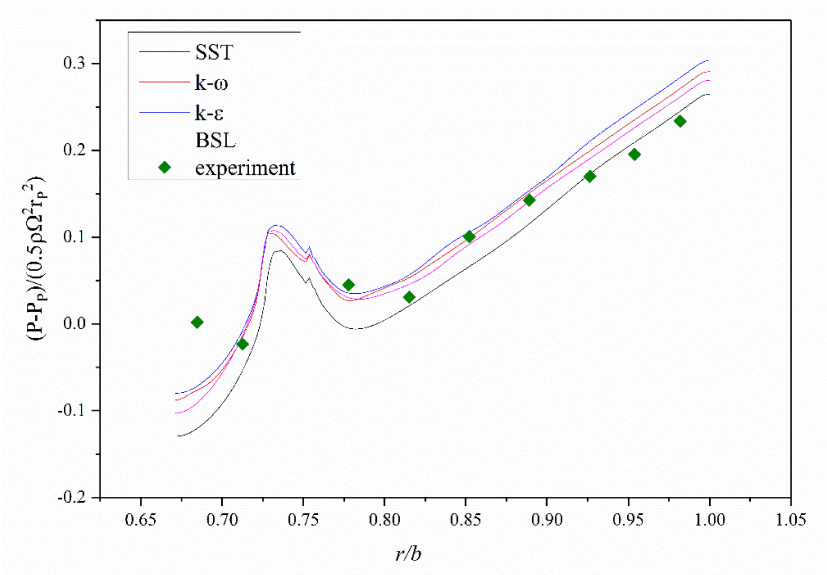
Figure 5. CFD static pressures at static disk versus experiment, λ T,P = 0.236, β p = 0.96.